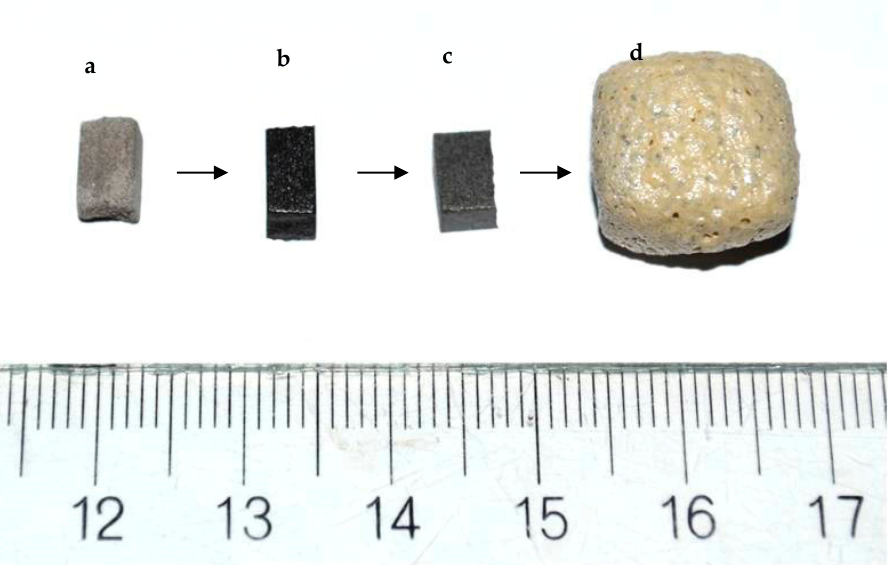
Figure 7. Photographs of the studied materials: ( a ) Press-powder; ( b ) Sintered glass-ceramics synthesized at 900 °C; ( c ) Self-glazed glass-ceramics obtained at 1020 °C; ( d ) Glass-ceramic foam sample bloated at 1100 °C.